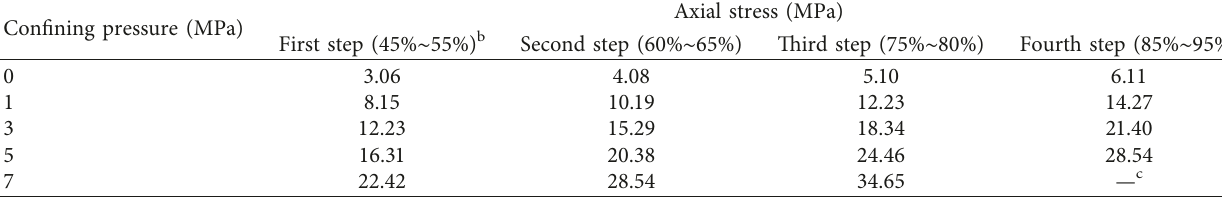
Table 3: The axial stress of each loading grade under different confining pressures.